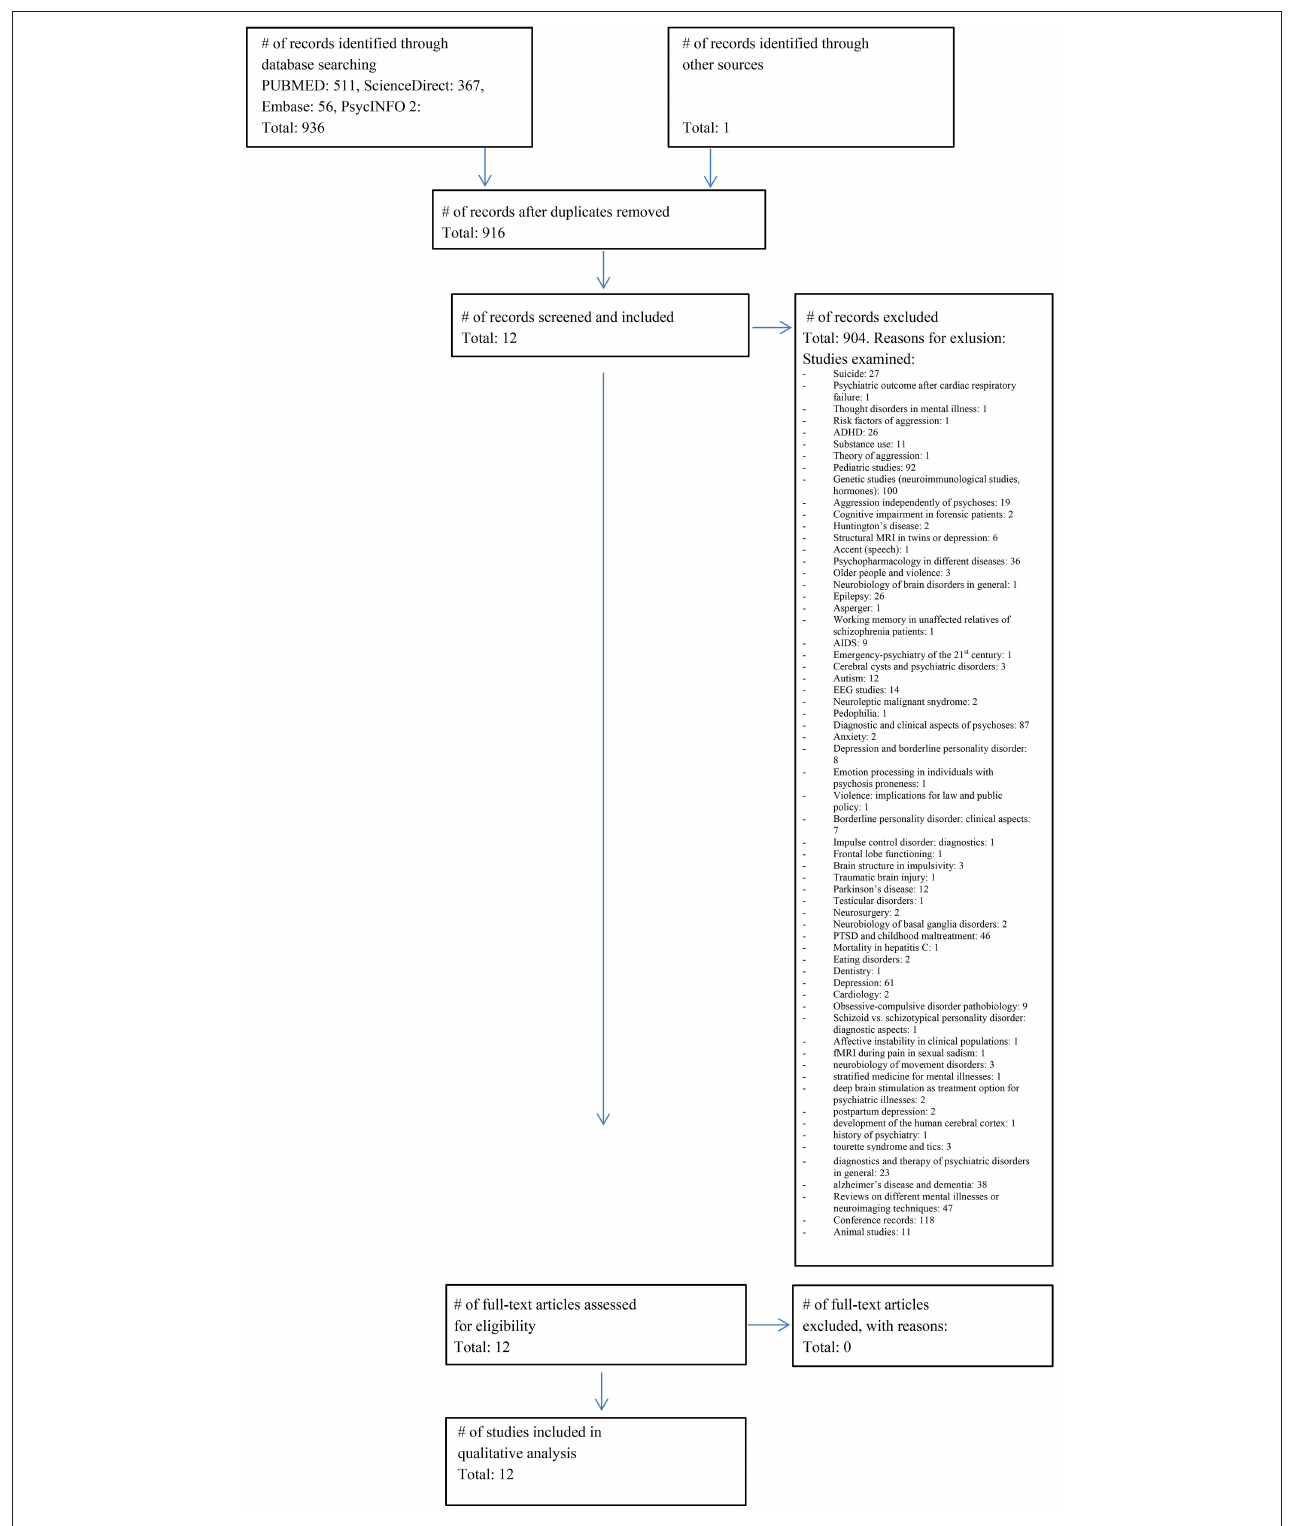
FIGURE 1 | Prisma flow chart. Flowchart of the literature search (03.09.2017) and included studies according to the PRISMA guidelines (20).